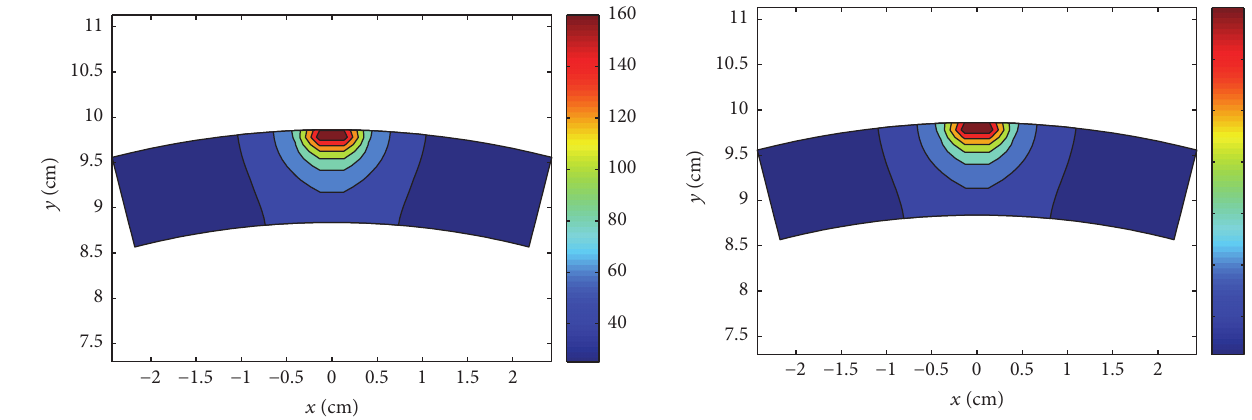
Figure 7: Temperature distribution at 𝑡 𝑓 = 30 s and 𝑁 1 = 15 .